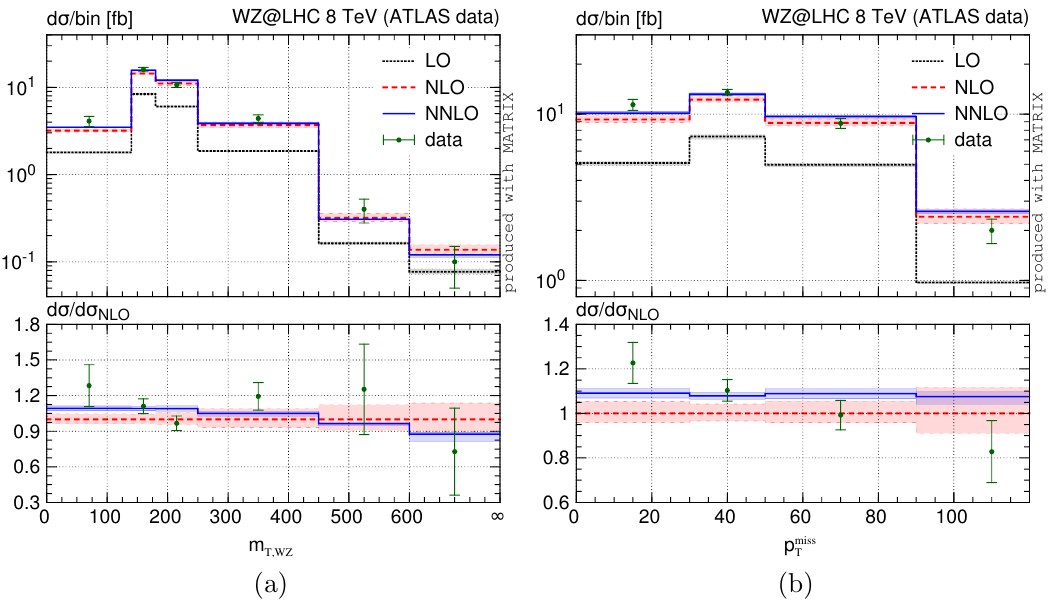
Figure 4 . Same as (cid:12)gure 3, but for (a) the transverse mass of the WZ system as de(cid:12)ned in eq. (3.3) and (b) the missing transverse energy.